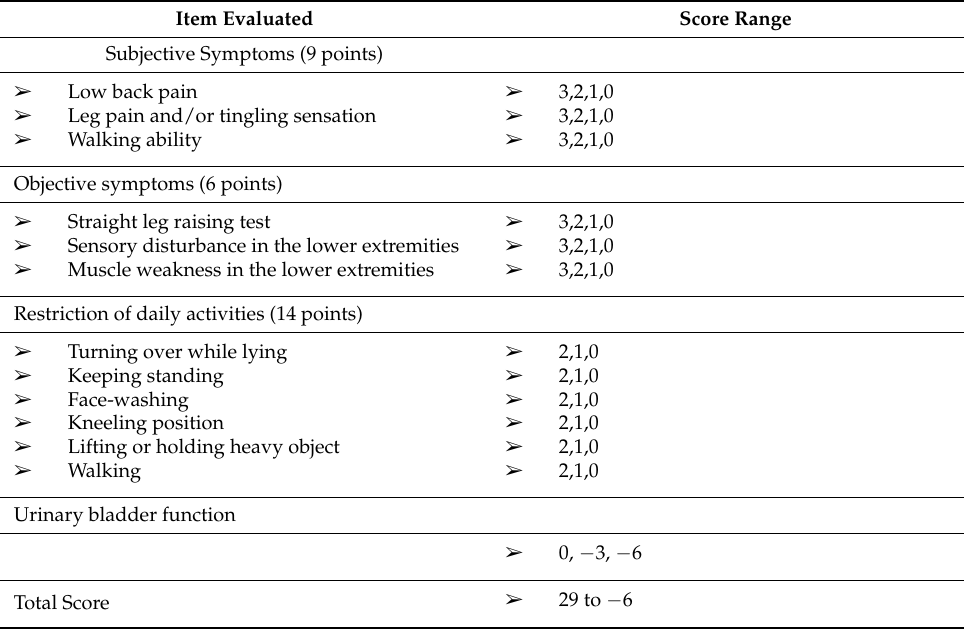
Table 2. The Japanese Orthopaedic Association